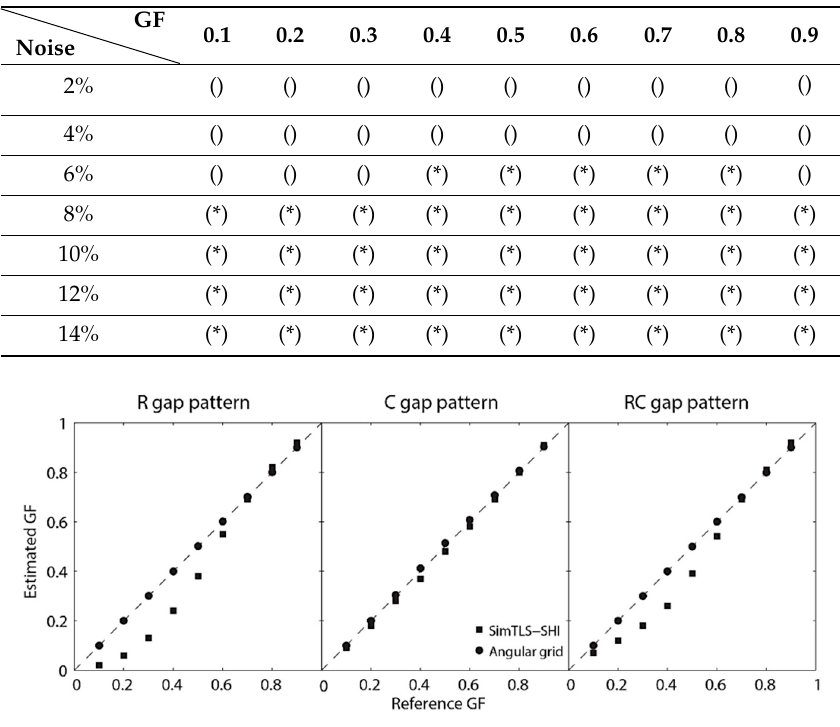
Figure 9. GF comparison for angular grid and Sim-TLS-SHI images. Data simulated with 6% noise.